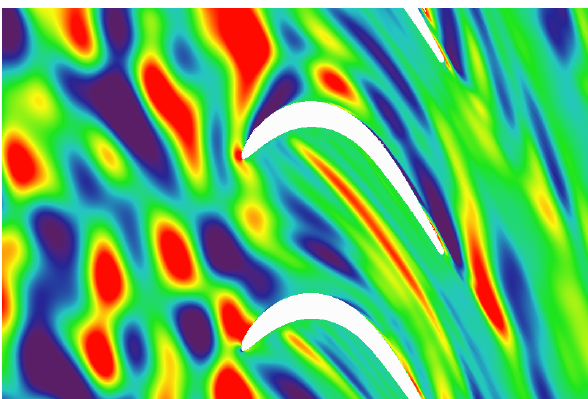
Figure 2. Time-instant reconstruction of vertical velocity, v (cid:48) , associated with the synthetic turbulent